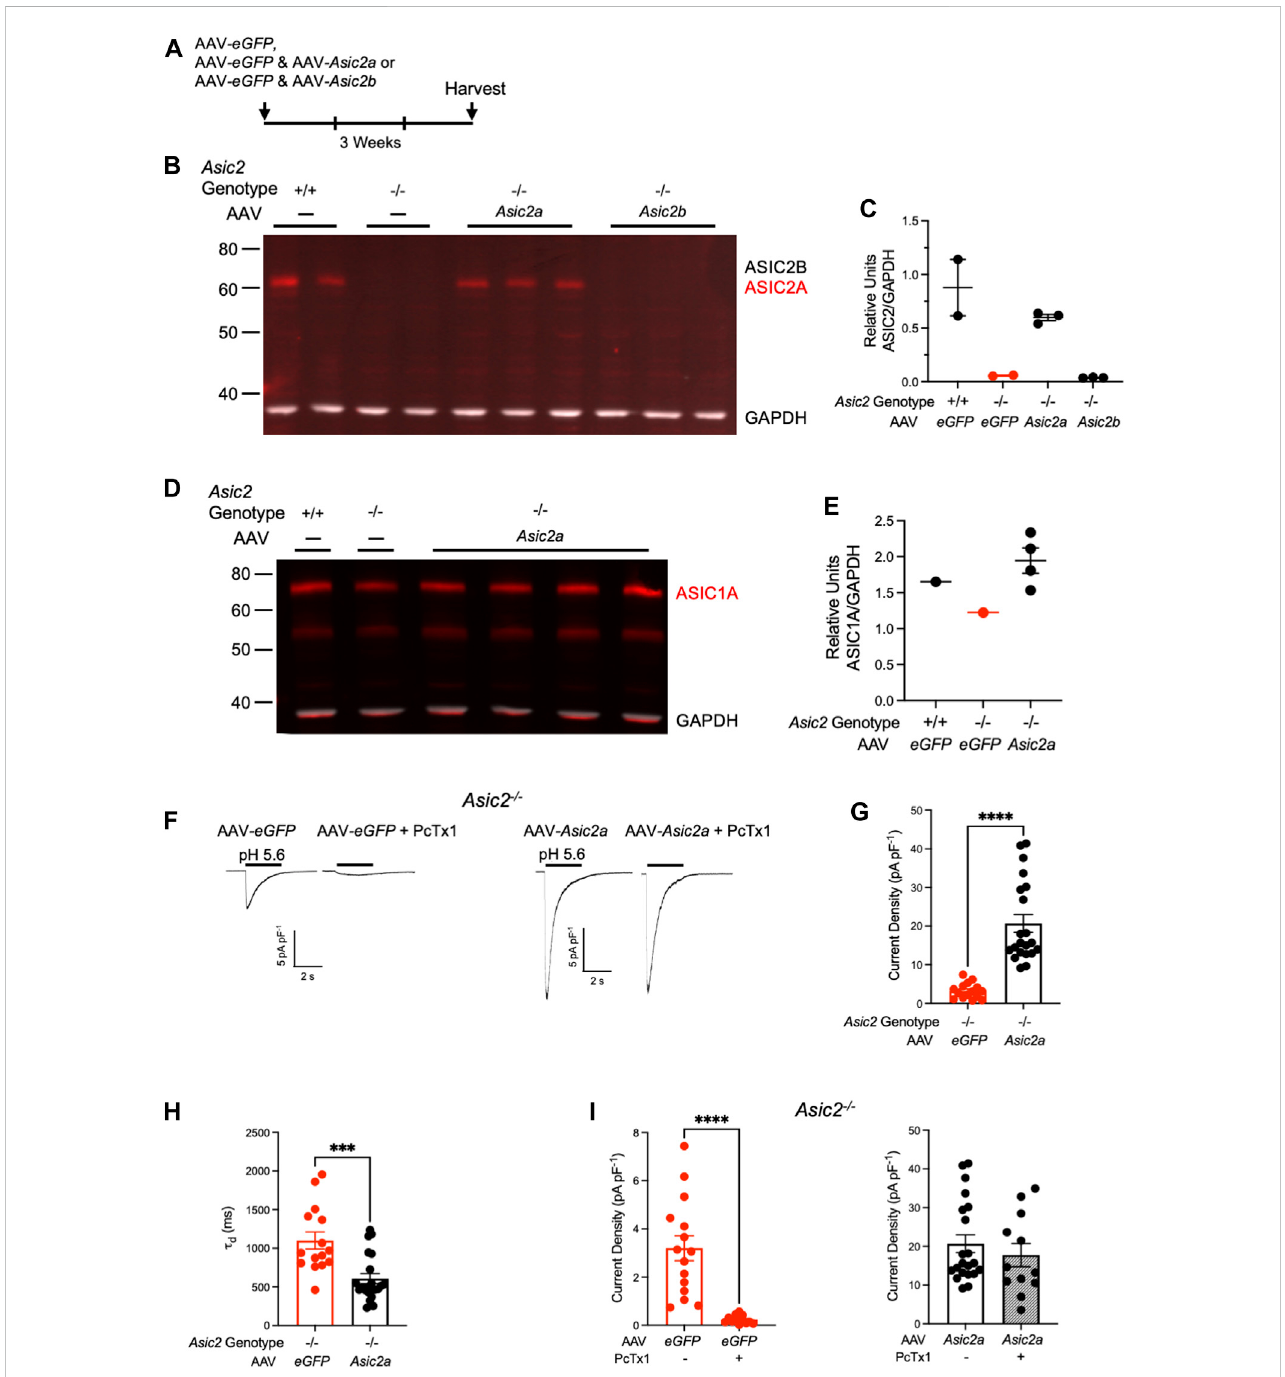
FIGURE 2 Expressing ASIC2A via AAV in NAcc of Asic2 − / − mice produced functional ASIC2A subunits that integrated with endogenous ASIC1A. (A) Timeline of virus injection prior to brain harvesting. (B) Western blot of ASIC2 in NAcc isolated from wild-type mice, Asic2 − / − mice and Asic2 − / − mice injected with ASIC2A or ASIC2B-expressing virus. Bands for ASIC2 protein are visible in wild-type mice and Asic2 − / − mice injected with AAV- Asic2a . No ASIC2 protein is visible in Asic2 − / − control or Asic2 − / − mice injected with AAV- Asic2b . (C) Quanti fi cation of western blot. ASIC2 signal from each lane was normalized to GAPDH signal. (D) Western blot of ASIC1A in NAcc isolated from wild-type mouse, Asic2 − / − mouse and Asic2 − / − mice injected with ASIC2A-expressing virus. Bands for ASIC1A protein are visible in each condition. (E) Quanti fi cation of western blot. ASIC1A signal from each lane was normalized to GAPDH signal. (F) Representative traces of EPSCs evoked by pH 5.6 in Asic2 − / − NAcc MSNs transfected with AAV -eGFP or AAV -Asic2a. Following acid-evoked current, selective ASIC blocker PcTx1 was applied in the same cells. (G) Comparing current density in Asic2 − / − NAcc MSNs reveals a signi fi cant effect of AAV- Asic2a on acid- evokedcurrent[t(22.01)=7.389, p < 0.0001,Welch ’ s t -test, n =15and21cells]. (H) Comparingratesofdesensitization( τ d )ofacid-evokedcurrentsin Asic2 − / − NAcc MSNs revealed a signi fi cant effect of AAV- Asic2a compared to controls injected with only AAV- eGFP [t (34) = 4.048, p = 0.0003, Student ’ s t -test, n = 15 and 21 cells]. (I) PcTx1 signi fi cantly reduced acid-evoked current in Asic2 − / − MSNs transfected with AAV- eGFP (left) [t (14.25) = 5.664, p < 0.0001, Welch ’ s t -test, n = 15 and 12 cells]. There was no effect of PcTx1 on acid-evoked current in Asic2 − / − MSNs transfected with AAV -Asic2a (right) [t (31) = 0.7707, p = 0.4467, Student ’ s t -test, n = 21 and 12